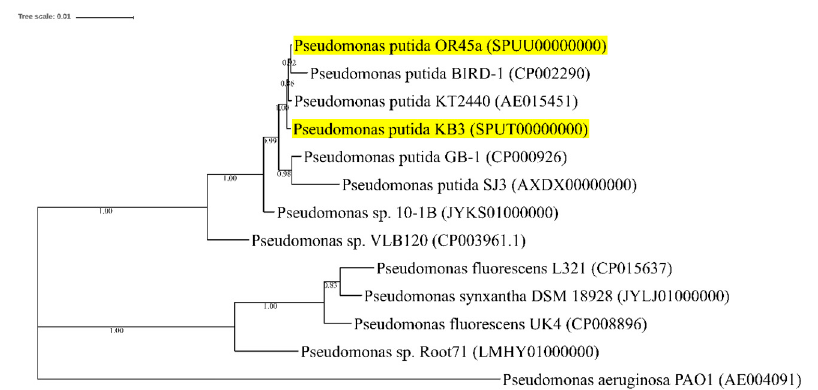
Figure 9. A maximum likelihood phylogenetic tree of the 13 Pseudomonas strains on the concatenation of 31 single-copy genes. P. putida OR45a and P. putida KB3 are indicated in yellow on the phylogenetic tree. The GenBank accession numbers are provided in the parentheses and the bootstrap support values are indicated on the nodes.